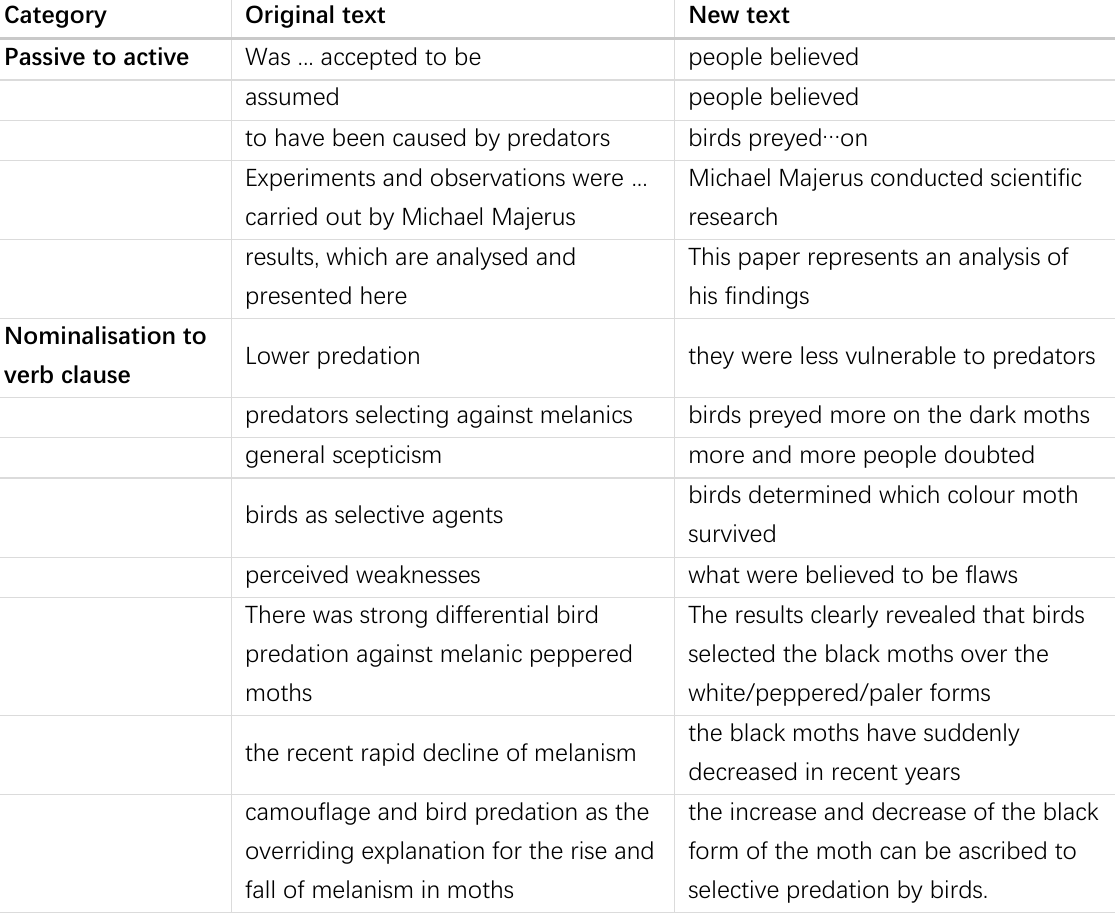
Table 1 : Instances of rewordings of passive voice to active voice and nominalisations to verb clauses in the joint rewriting of the Abstract from Cook, et al.